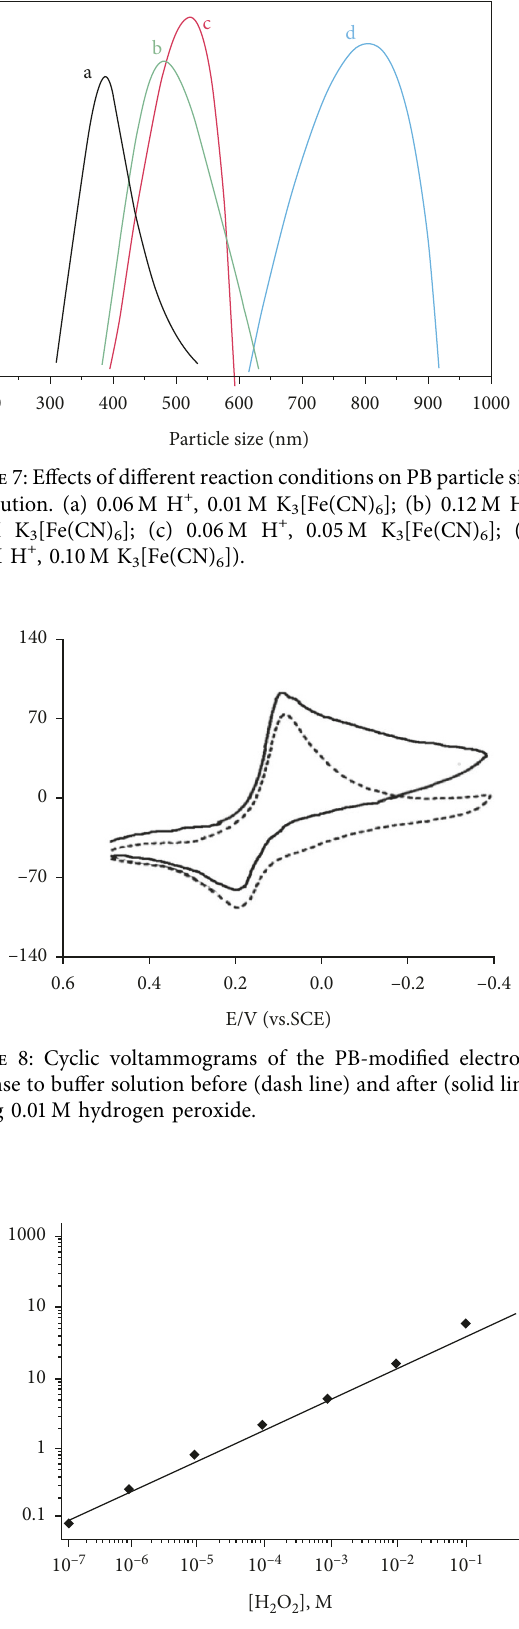
2 O 2 detection with the PB-mod-